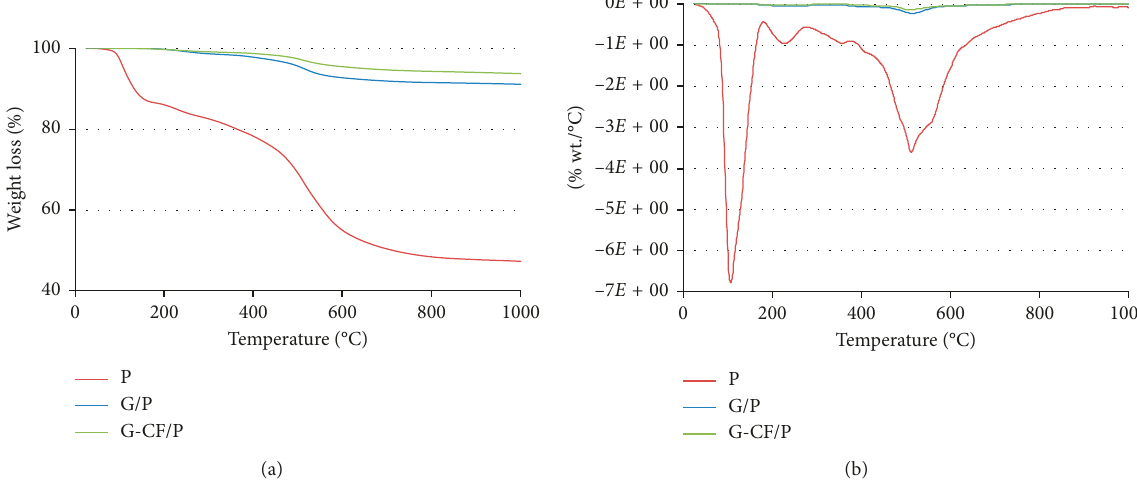
Figure 5: Thermal analysis of P, G/P, and G-CF/P composites: (a) TGA diagram and (b) DTG diagram.